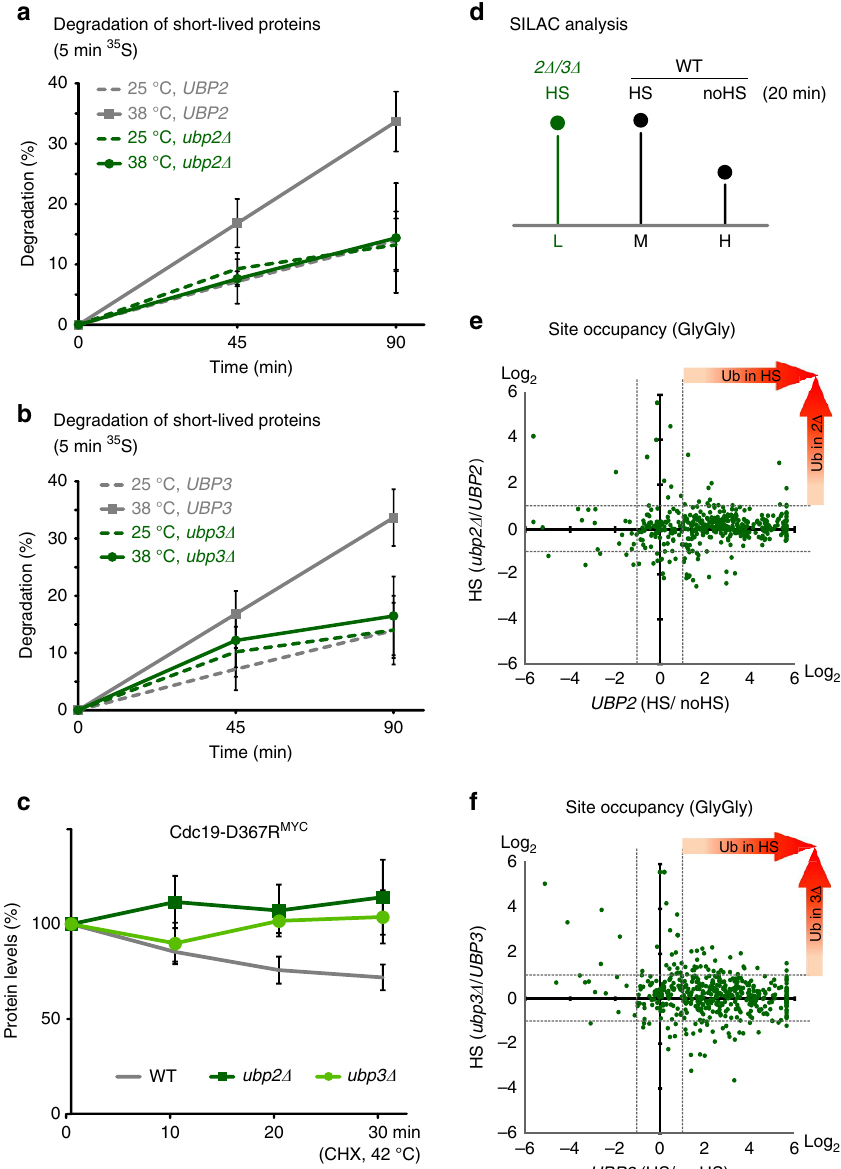
Figure 3 | Ubp2 and 3 share substrate pools and are required for the degradation of misfolded proteins upon HS. ( a , b ) Degradation of 35 S pulsed- labelled proteins (5min) in WT (grey) and indicated deletion strains (green) cells at 25 (cid:2) C (dotted lines) or 38 (cid:2) C (straight lines). The portion of proteins degraded at the indicated times was reported from three independent experiments with s.d. ( c ) Turnover of plasmid-expressed Cdc19-D367R 13MYC in designated cells at 42 (cid:2) C was assessed by western blots after the addition of 100 m gml (cid:2) 1 cycloheximide. The Pgk1-normalized protein levels were averaged from three independent experiments and shown with s.d. ( d ) Schematic representation of the triple-SILAC experiment to quantify conjugated substrate peptides. L, M, and H denote the three different SILAC-labels (light, medium and heavy). ( e , f ) Scatter plots of the log 2 ratios of quantified conjugated peptides. In the x axis, ratios of M versus H are shown to display sites affected by heat-stress in WTcells. In the y axis, ratios of L versus M are reported to display sites affected by the absence of UBP2 ( e ) or UBP3 ( f ) upon